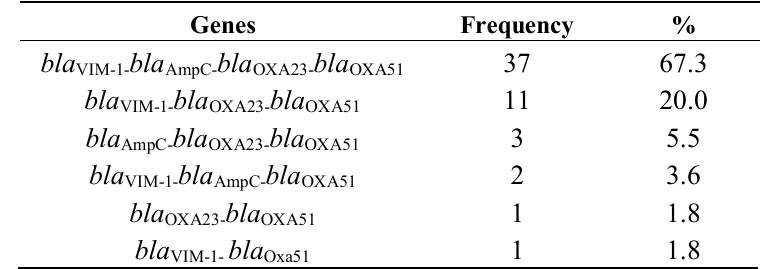
Table 2. Frequencies of different combinations of β-lactamases genes in A. baumannii strains (n =